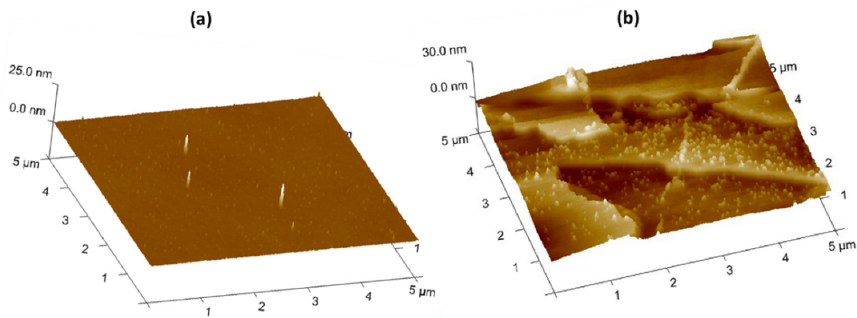
Figure 4. Bare Si wafer ( a ) and PEGylated IONPs dried on Si wafer ( b ). Comparison of the bare and coated substrates show topographical variation. The AFM images show an increased roughness due to the presence of the PEG layer (Figure 4b). The brighter spots on Figure 4b, might indicate presence of the IONPs within the PEG layer, confirming what was already seen in the TEM images.